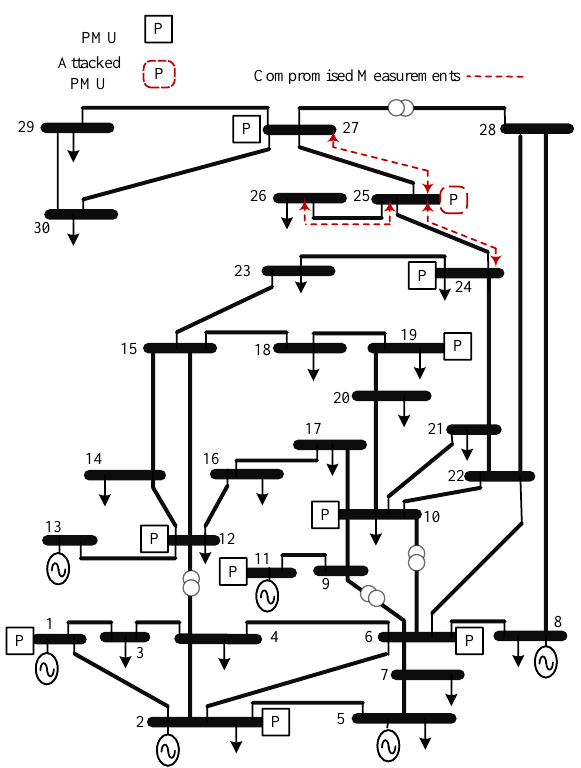
Figure 4. IEEE 30-bus test system